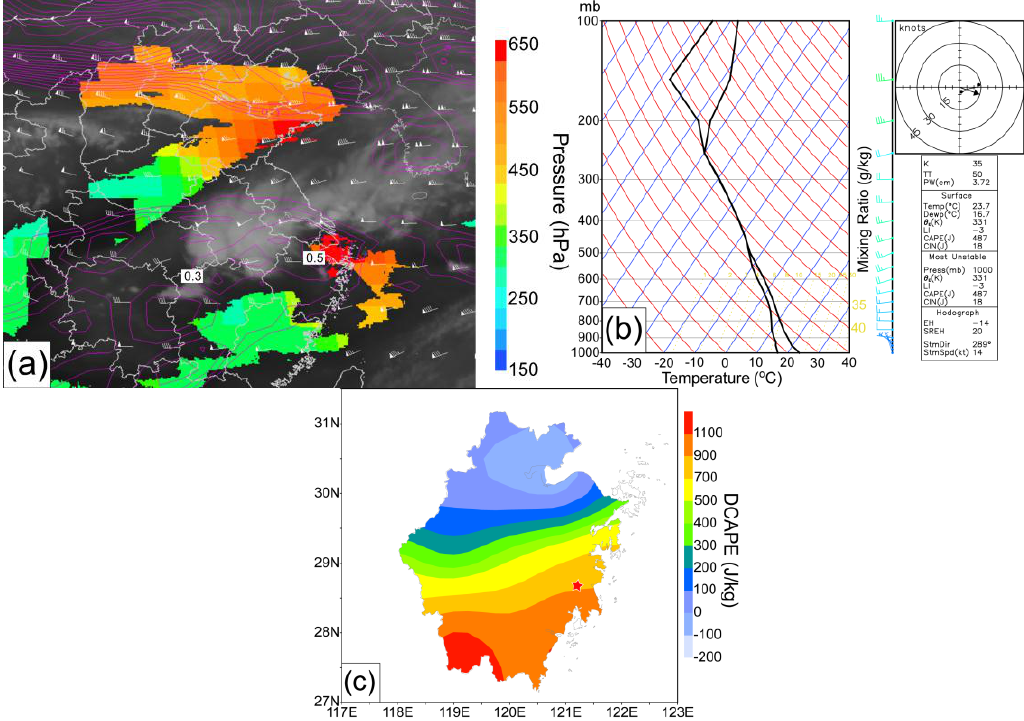
Figure 10. ( a ) The composition map of dry intrusion(shadings) and positive vorticity (contours, unit: 10 −4 s −1 ) at 315 K isentropic layer at 10:00 LST 19 Mar 2014. ( b ) skew T log-P diagram at the location shown with starisk in Figure 9a; ( c ) DCAPE distribution within Zhejiang province (The starisk denotes the location of Taizhou city).